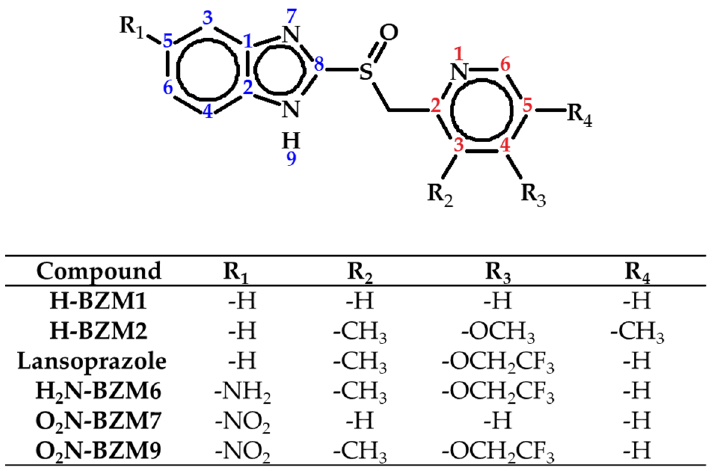
Figure 2. Chemical structure of synthesized 2-mercapto-benzimidazoles, the numbering of the benzimidazole and pyridine core in blue and red color.